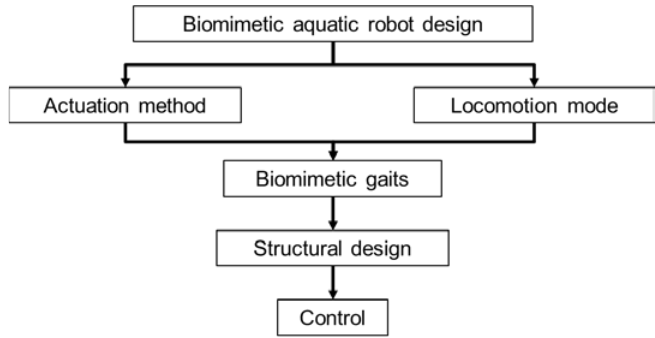
Figure 9. Roadmap for biomimetic robot design.